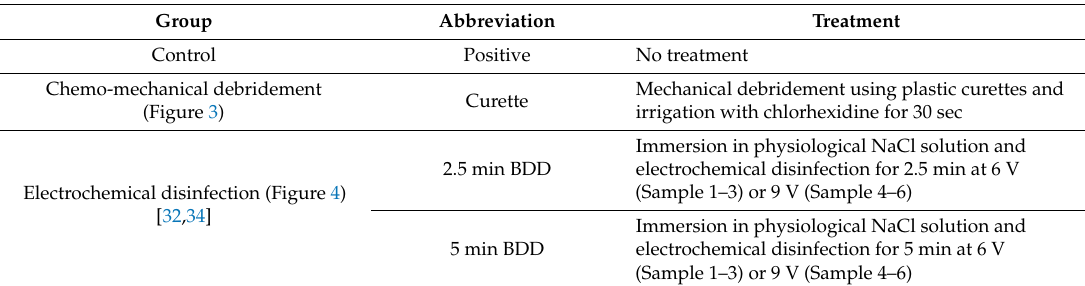
Table 1. Treatment